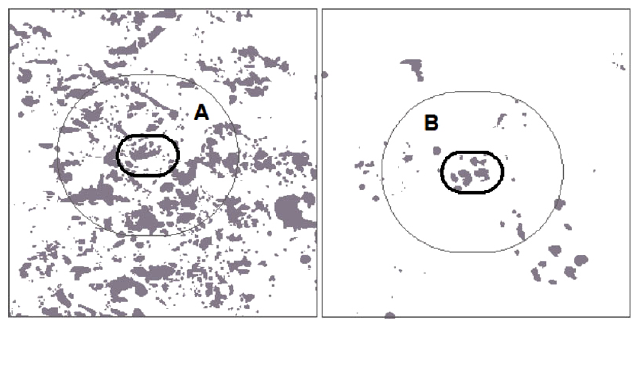
Fig. 1 . Schematic representation of hypotheses regarding interaction of proximate and landscape scales. The two inner ovals each have 50% tree cover, but there is more tree cover surrounding oval A. The no-effect hypothesis (H0) predicts that there is no difference in the probability of a woodland bird occurring in the two inner ovals. The tolerance hypothesis (H1) would suggest that a woodland species is more likely to occupy patches in B than in A, because it has few alternatives. The avoidance hypothesis (H2) would suggest that a woodland species is less likely to occur in B than in A.